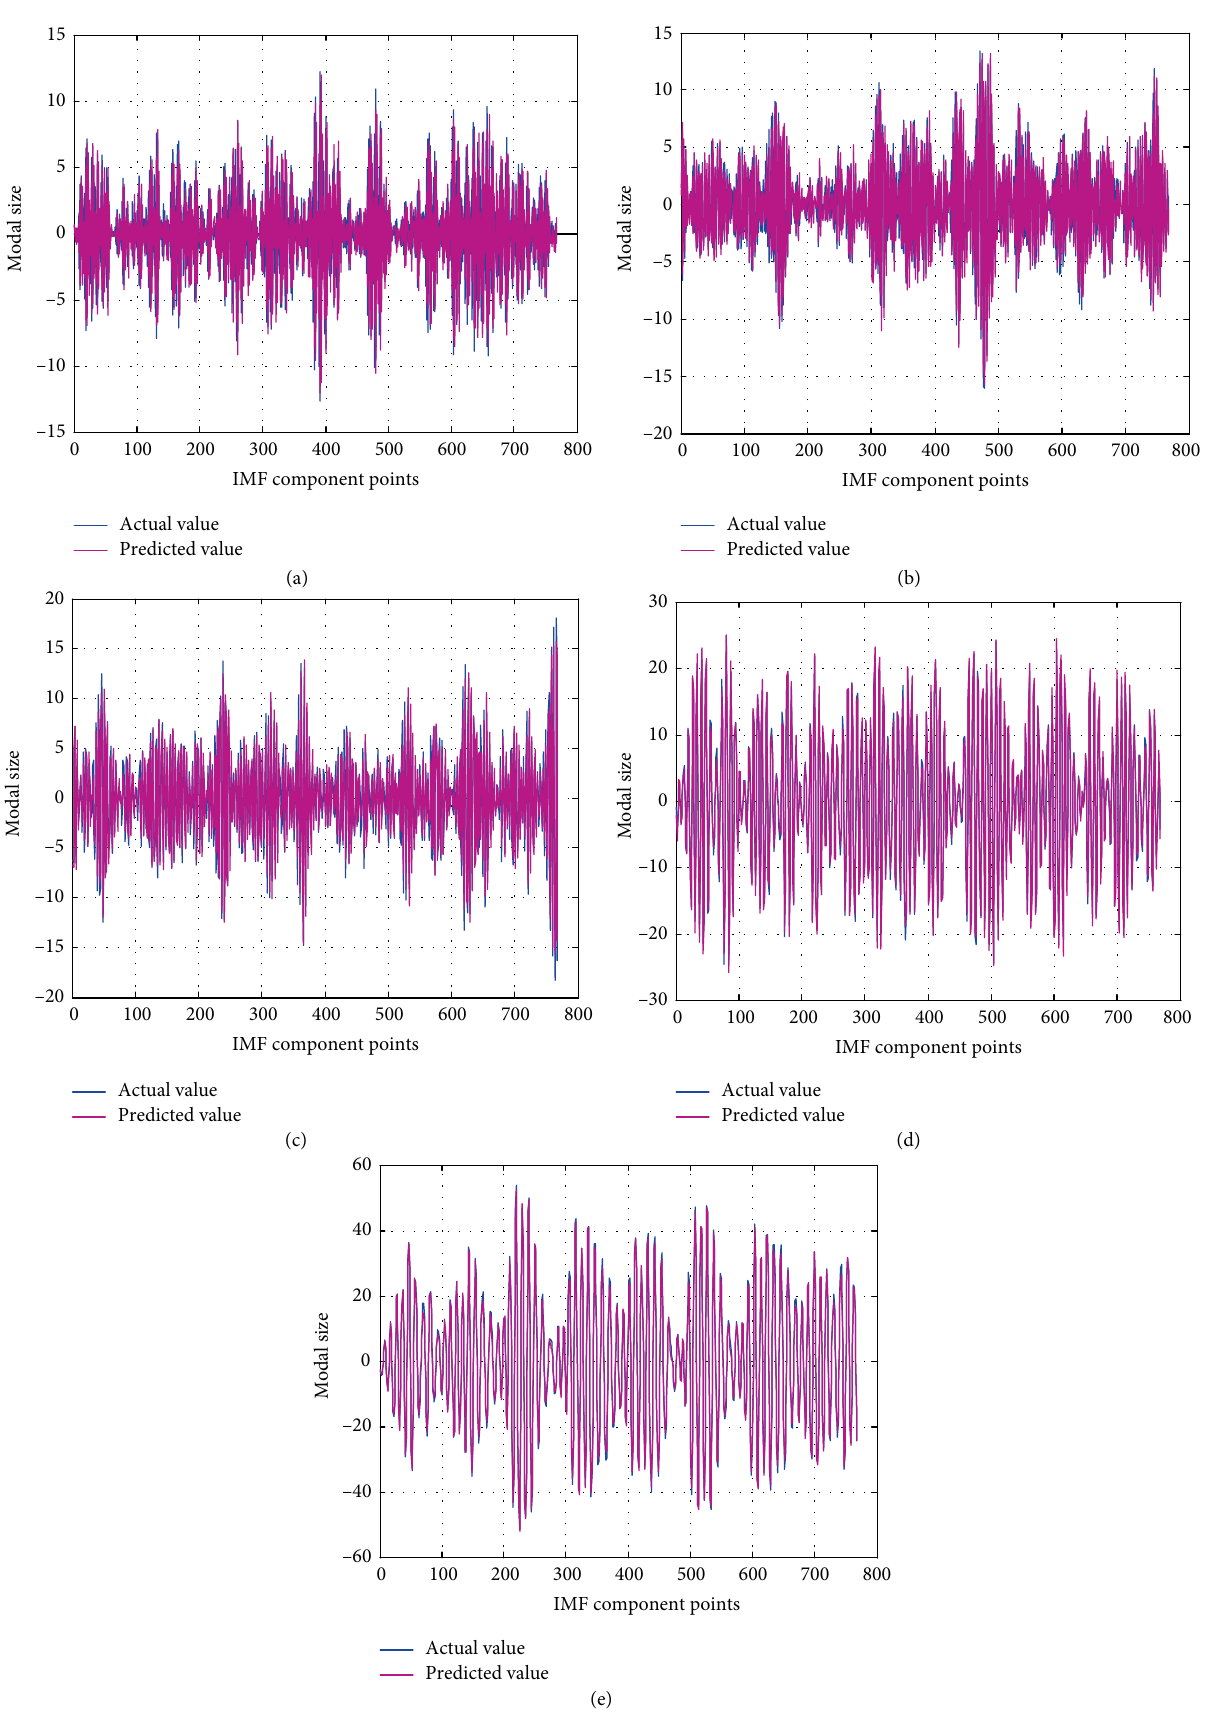
Figure 8: High frequency component prediction figure. Prediction results of (a) IMF1, (b) IMF2, (c) IMF3, (d) IMF4, and (e)